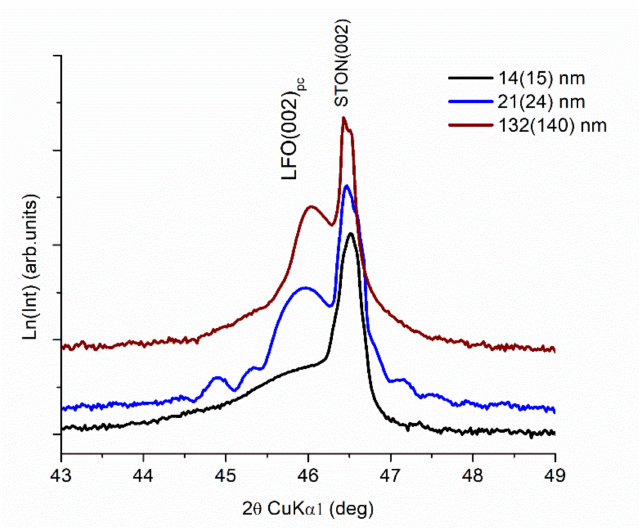
Figure 3. The θ –2 θ patterns for thin films around the (002) pc reflection for LFO/STON thin films with different thicknesses.